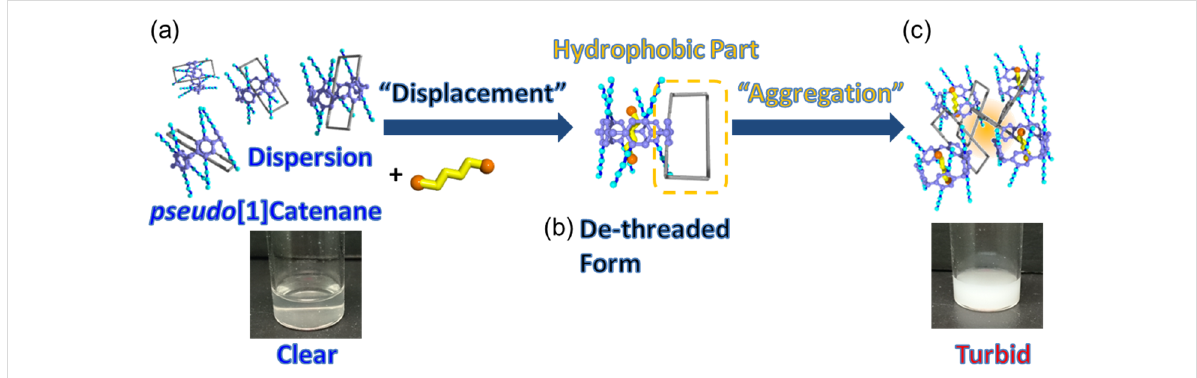
Figure 4: Photographs of (a) 3 and (c) a mixture of 3 (2 mM) and 1,4-dicyanobutane (20 mM) in aqueous media at 20 °C and schematic representa- tion of neutral-guest responsive clouding point change using supramolecular structural change from pseudo [1]catenane to de-threaded form upon (b) addition of a competitive guest,